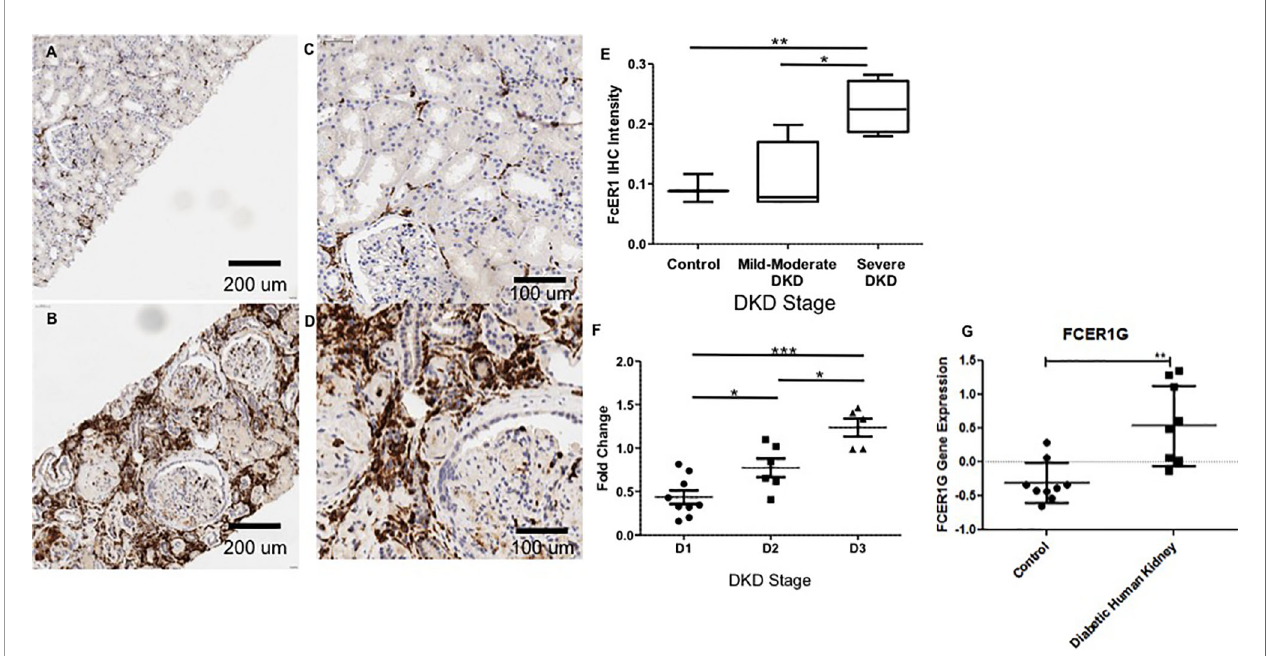
FIGURE 5 | Representative Immunohistochemistry staining for FcER1 in human kidney tissue. (A) Normal kidney at 20x. (B) Diabetic kidney at 20x. (C) Normal kidney at 40x. (D) Diabetic kidney at 40x. (E) The intensity of FcER1 staining in human kidney tissue. (F) Gene expression of FcER1 from PBMCs at different stages of diabetic kidney disease. (G) Gene expression of FcER1 in control and diabetic kidney disease; *p < 0.05, **p < 0.01, ***p < 0.001; DKD, diabetic kidney disease; D1, diabetes with normoalbuminuria; D2, diabetes with microalbuminuria; D3, diabetes with